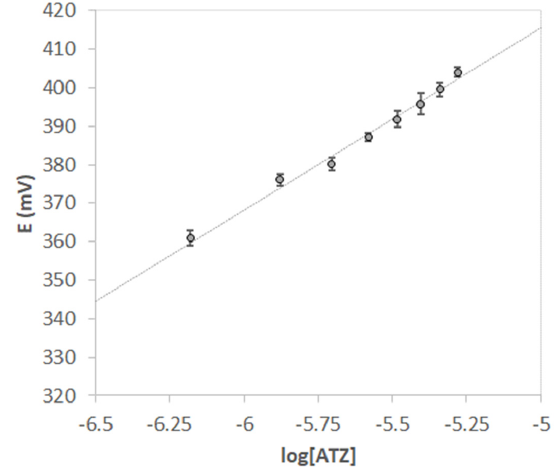
Figure 6. Nernst’s plot E vs. log [ATZ]. V = 15 mL of HCl pH = 1.5. Each point is the mean of 5 measurements obtained with different screen-printed cells. Error bars correspond to the standard deviation of the measurements.